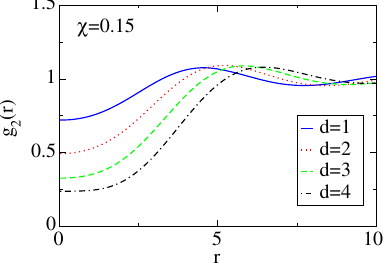
FIG. 8. Theoretical predictions for the pair correlation function g 2 ð r Þ for χ ¼ 0 . 15 across the first four space dimensions. Here, K ¼ 1